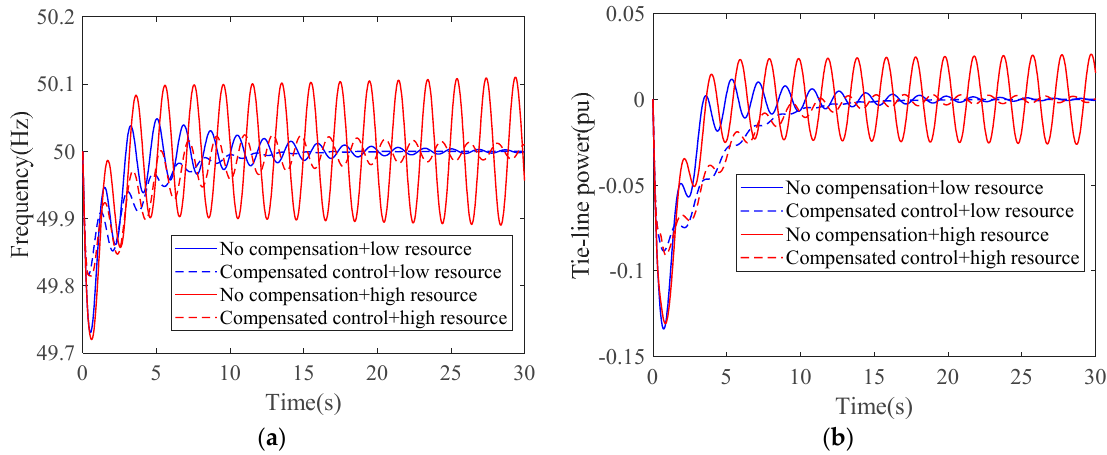
Figure 17. Contrast of control effects with or without network delay compensator in the IEEE 57-bus system. ( a ) Control effects of frequency; ( b ) control effects of tie-line power.